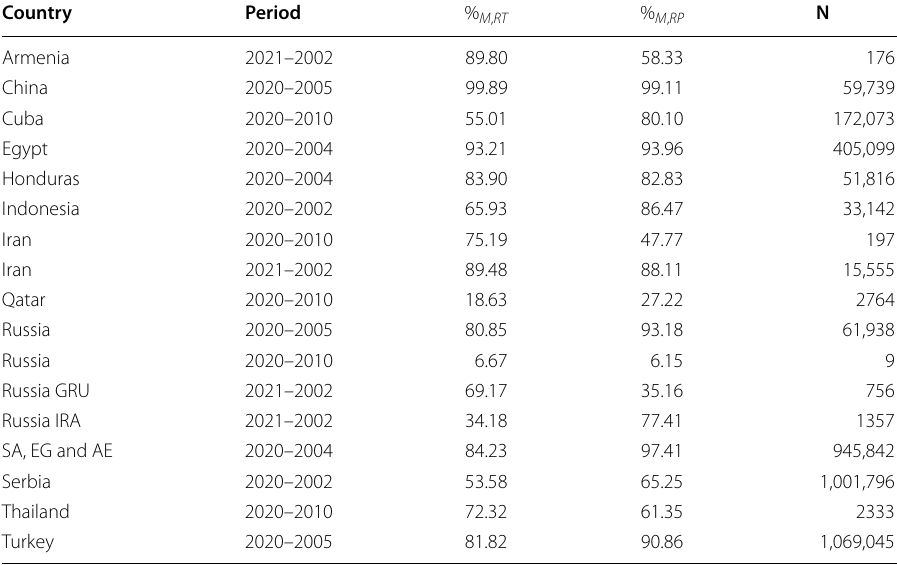
Table 2 Overview of matching edges between the weighted, directed and the projected bipartite network Country Period % M , RT % M , RP